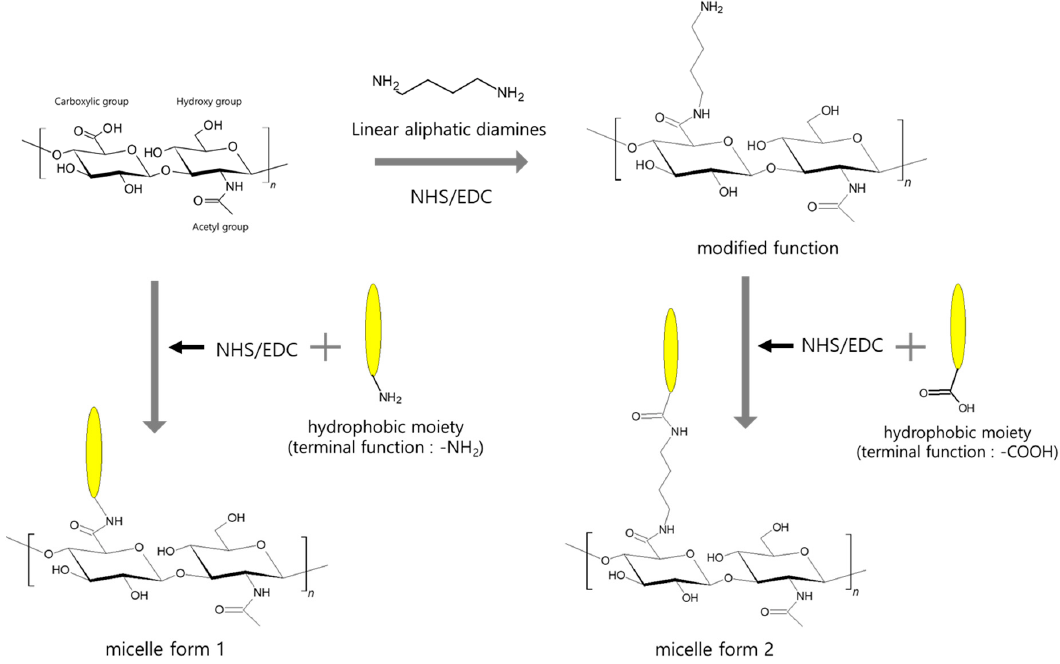
Figure 2. Chemical modification of hyaluronic acid for binding hydrophobic molecules to form micelles.